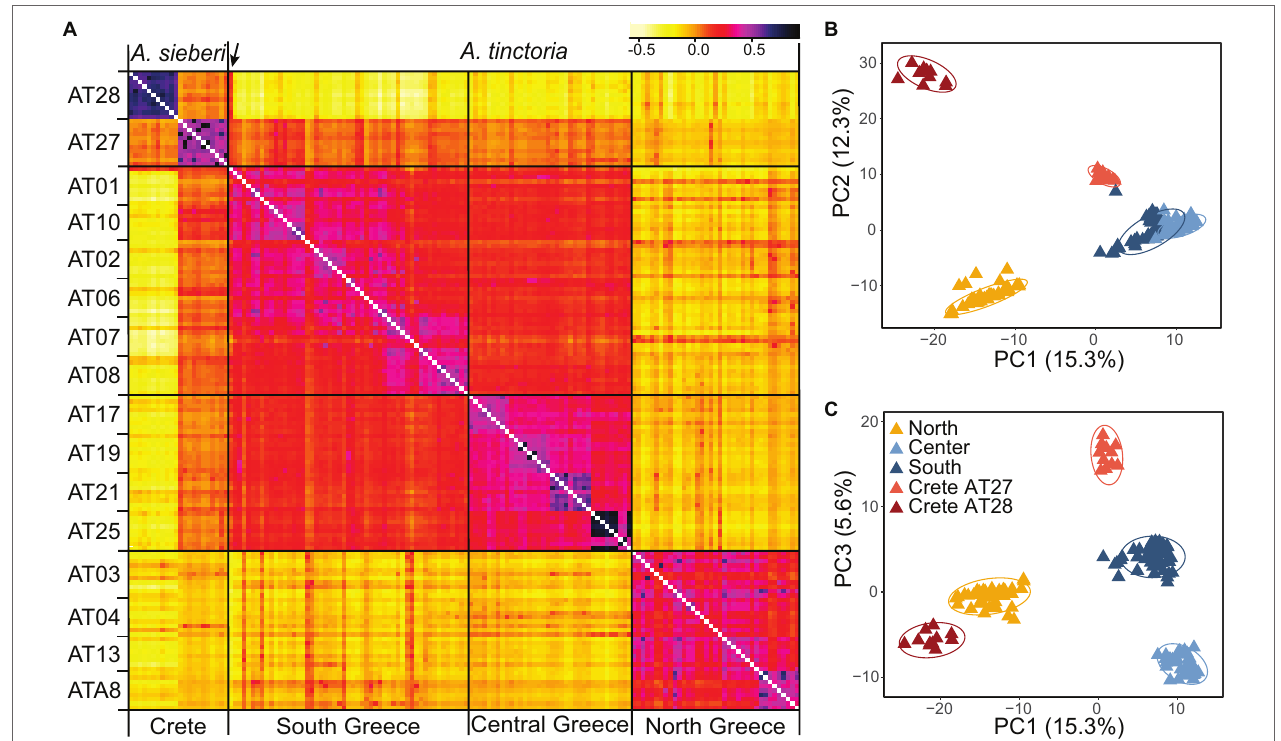
FIGURE 3 | Genomic variation in Alkanna . (A) Heatmap of pairwise relatedness between 148 individuals from 16 different localities across Greece based on 16,107 SNPs present across all individuals. Regional origins of individuals are given below the heatmap, and each population is indicated on the left side of the heatmap. Darker colors represent higher relatedness, according to the legend included on the top right side. For improved color resolution, the estimates on the diagonal were excluded. An arrow points to a potentially admixt individual in population AT01 that is discussed in the text. (B,C) Genetic structure in the Greek Alkanna populations inferred based on EBG-derived tetraploid genotypes ( n = 148) as revealed by principal component analysis